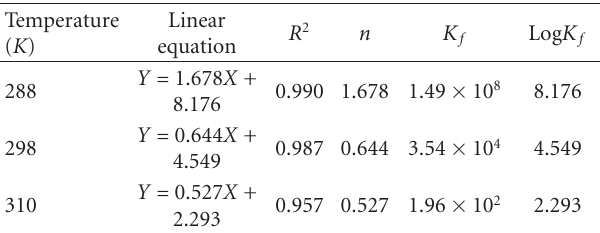
Table 2: Binding constants ( K f ) and the number of binding sites ( n ) of the complex DNA